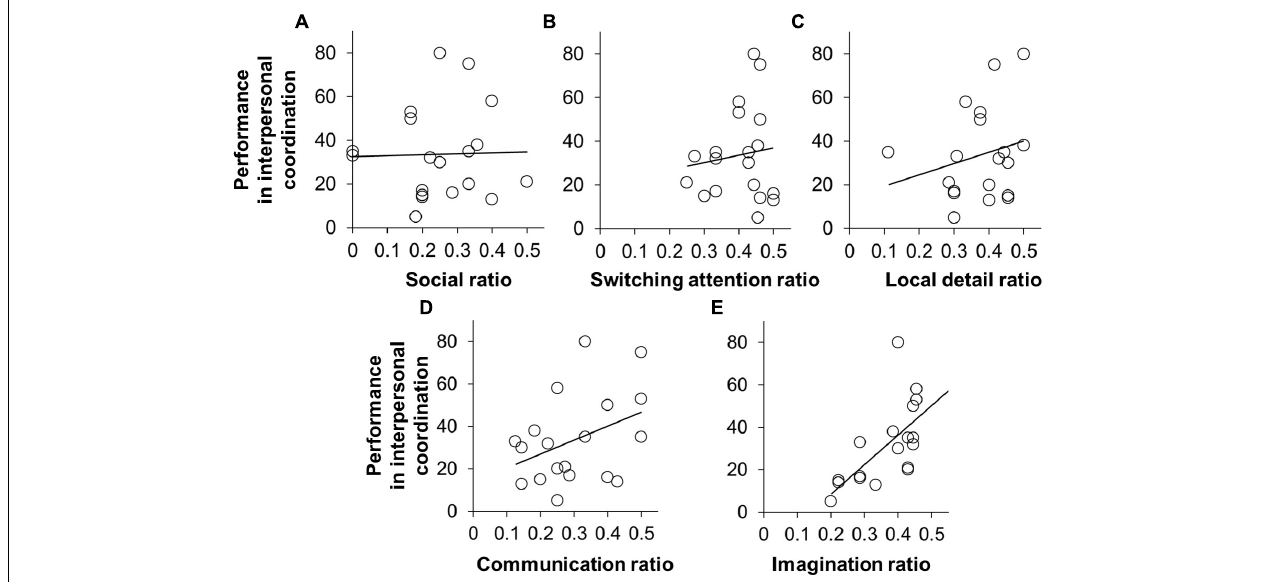
FIGURE 3 | The scatter plots between AQ subscale ratio and the performance value in IMC; social skills ratio (A) , attention-switching ratio (B) , attention to detail (C) , communication ratio (D) , and imagination ratio (E) . The Pearson product-moment correlation between the imagination ratio and the IMC performance value was significant ( r = 0.73, p = 0.001, after Bonferroni correction).